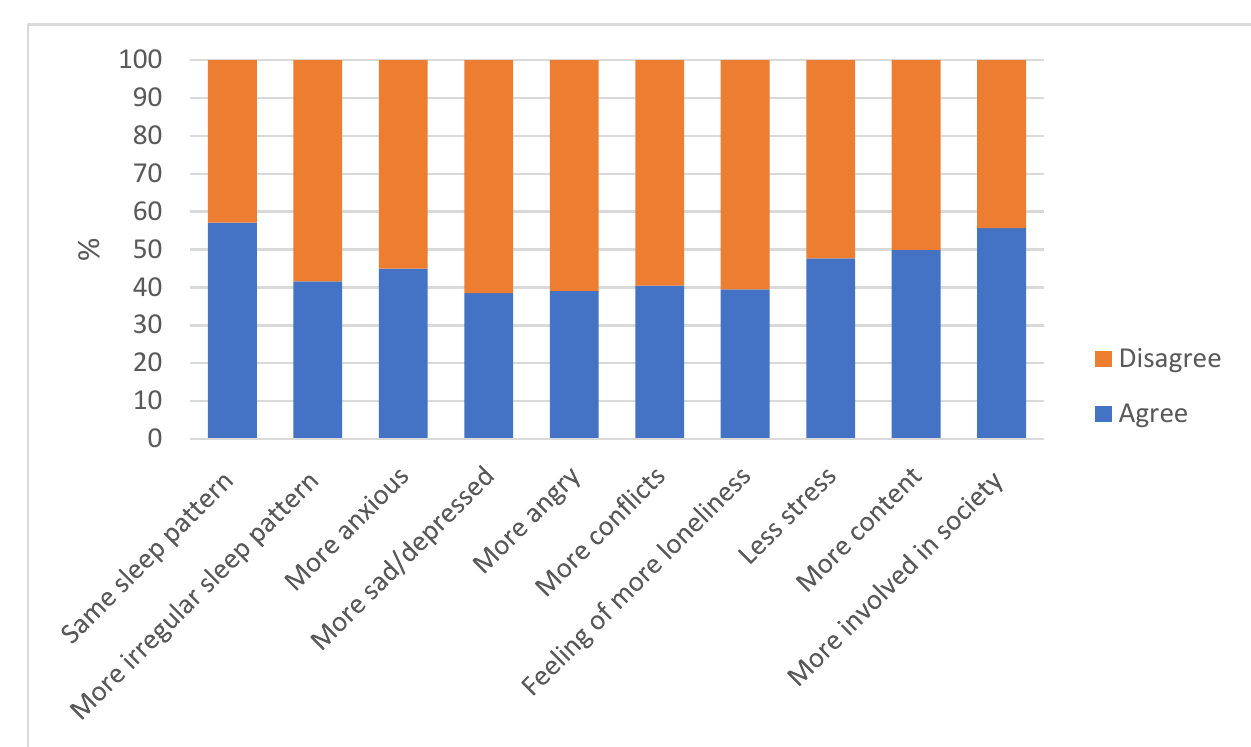
Figure 4. Changes in mental health factors caused by the COVID-19 outbreak in the global study population. About two-thirds of the high school students did not feel angrier (60.9%), sadder (61.5%), or lonely (60.5%), and more than half did not feel more anxious (55.0%), did not get into arguments more often (59.5%), did not mark changes in their sleep patterns (57.1%–58.4%), and even felt more involved in society (55.7%) after the COVID-19 out- break. However, about half of them also felt more stressed (52.3%) and less content or fulfilled